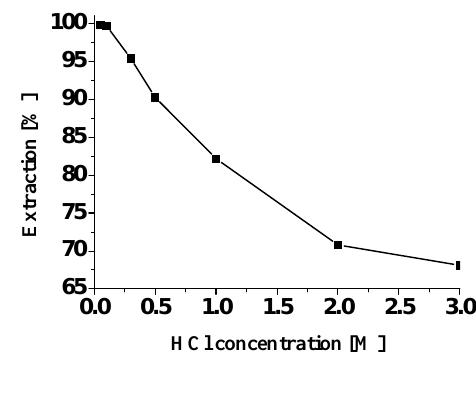
Figure 2 . Effect of extractant concentration on the percentage extraction of palladium. [Pd(II)] = 100 mg·L -1 ; ■ : 0.1 M HCl; ▲ : 2.0 M HCl.